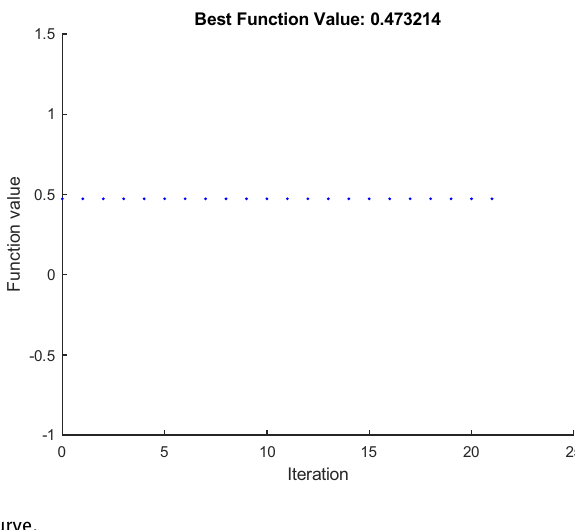
Figure 5: PSO convergence